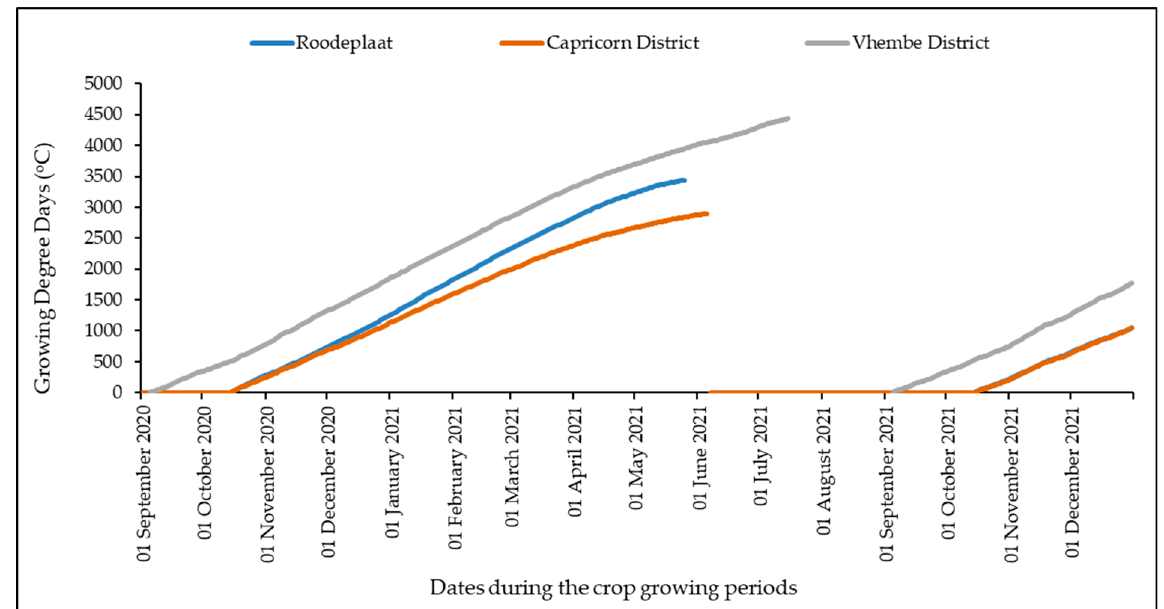
Figure 5. Thermal time accumulation (expressed in Growing Degree Days–GDD) of Moringa oleifera across the three study regions of South Africa, from September 2020 (period after dormancy) to the beginning of the first sprouts in November–December 2021.